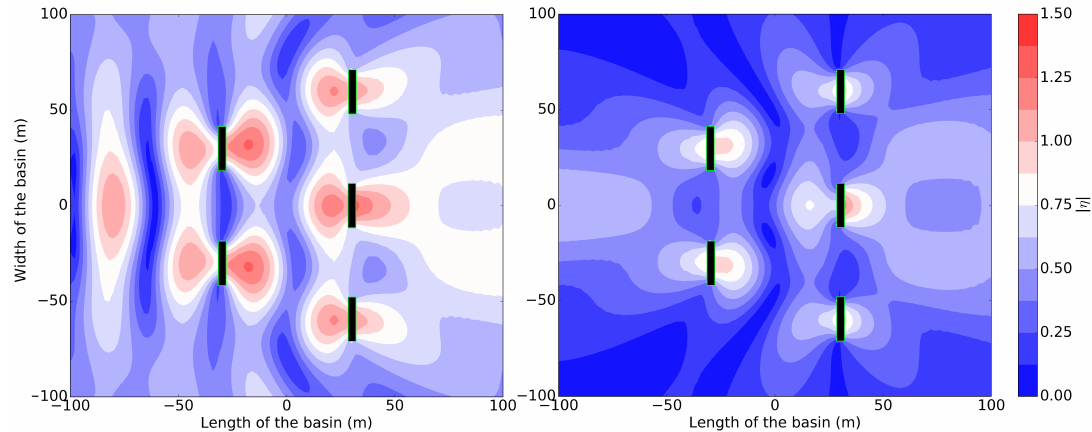
Figure 18. The total ( left ) and perturbed ( right ) | η | for an array of heaving cylindrical WECs for H = 1.0 m, T = 8.0 s for a linear PTO system. Incident wave propagating from the